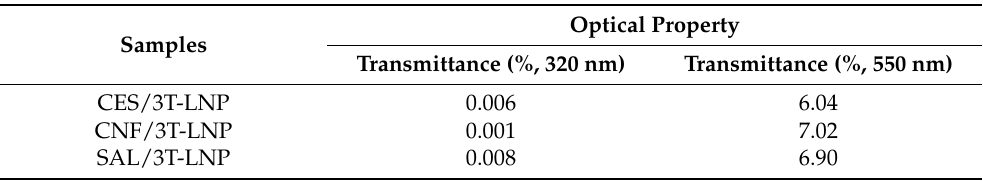
Table 5. Anti-ultraviolet performance comparison of composite films from historical